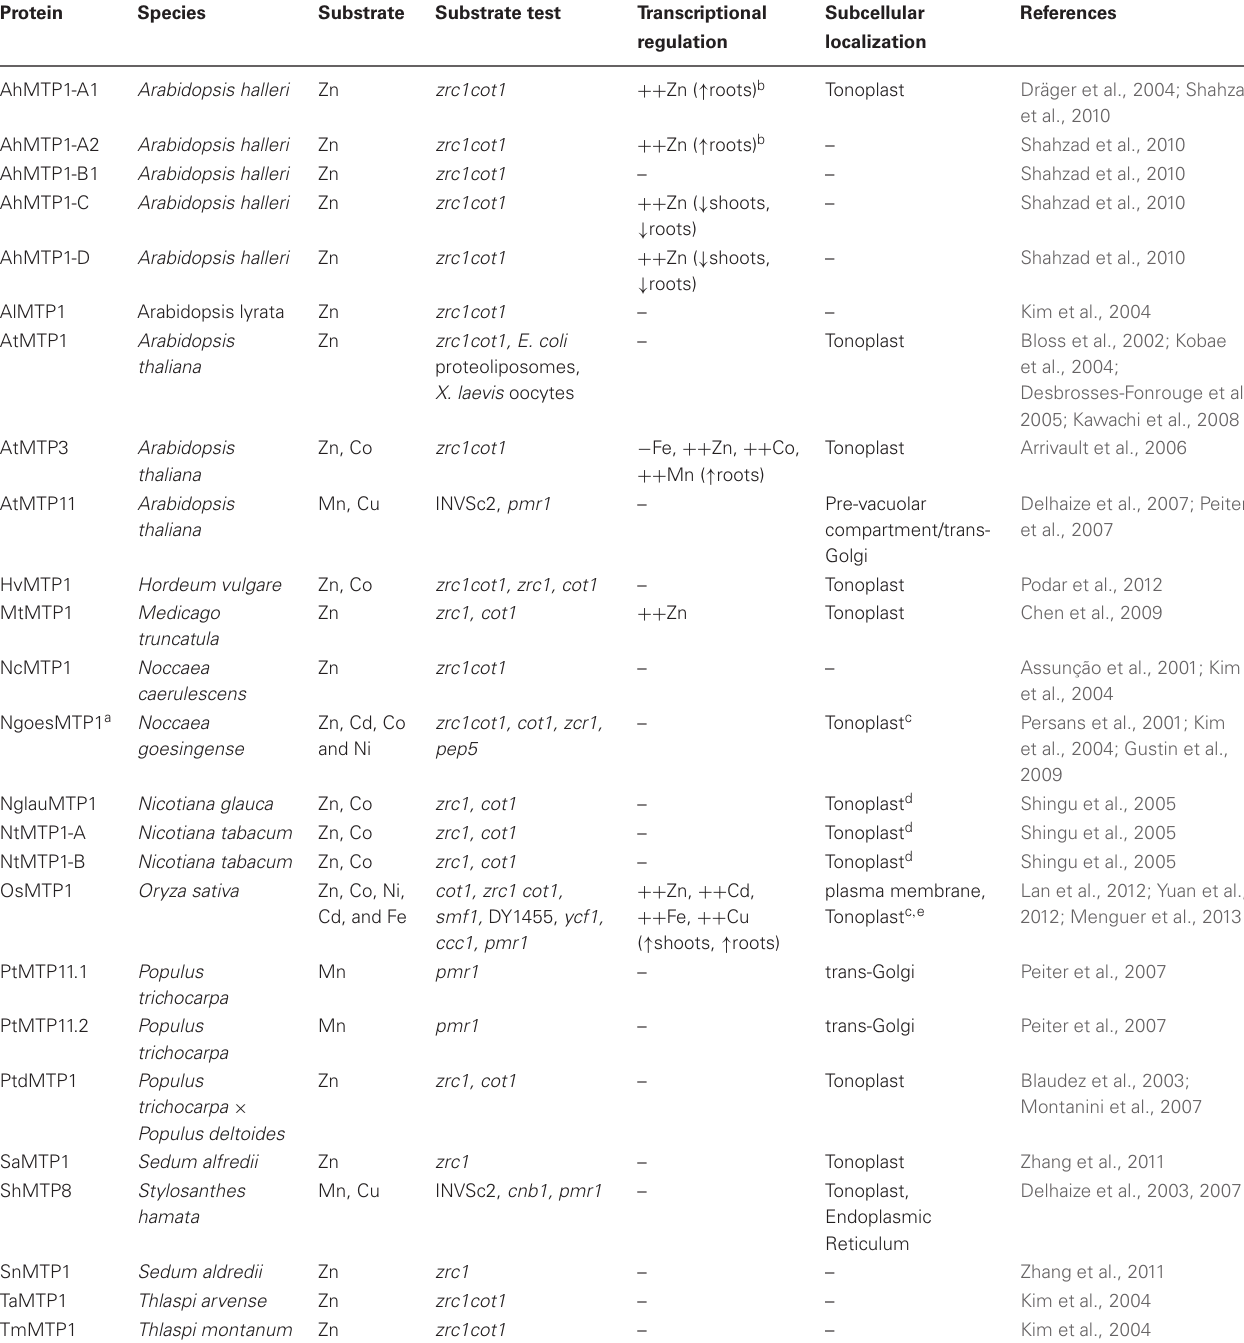
Table 1 | Functionally characterized plant MTP